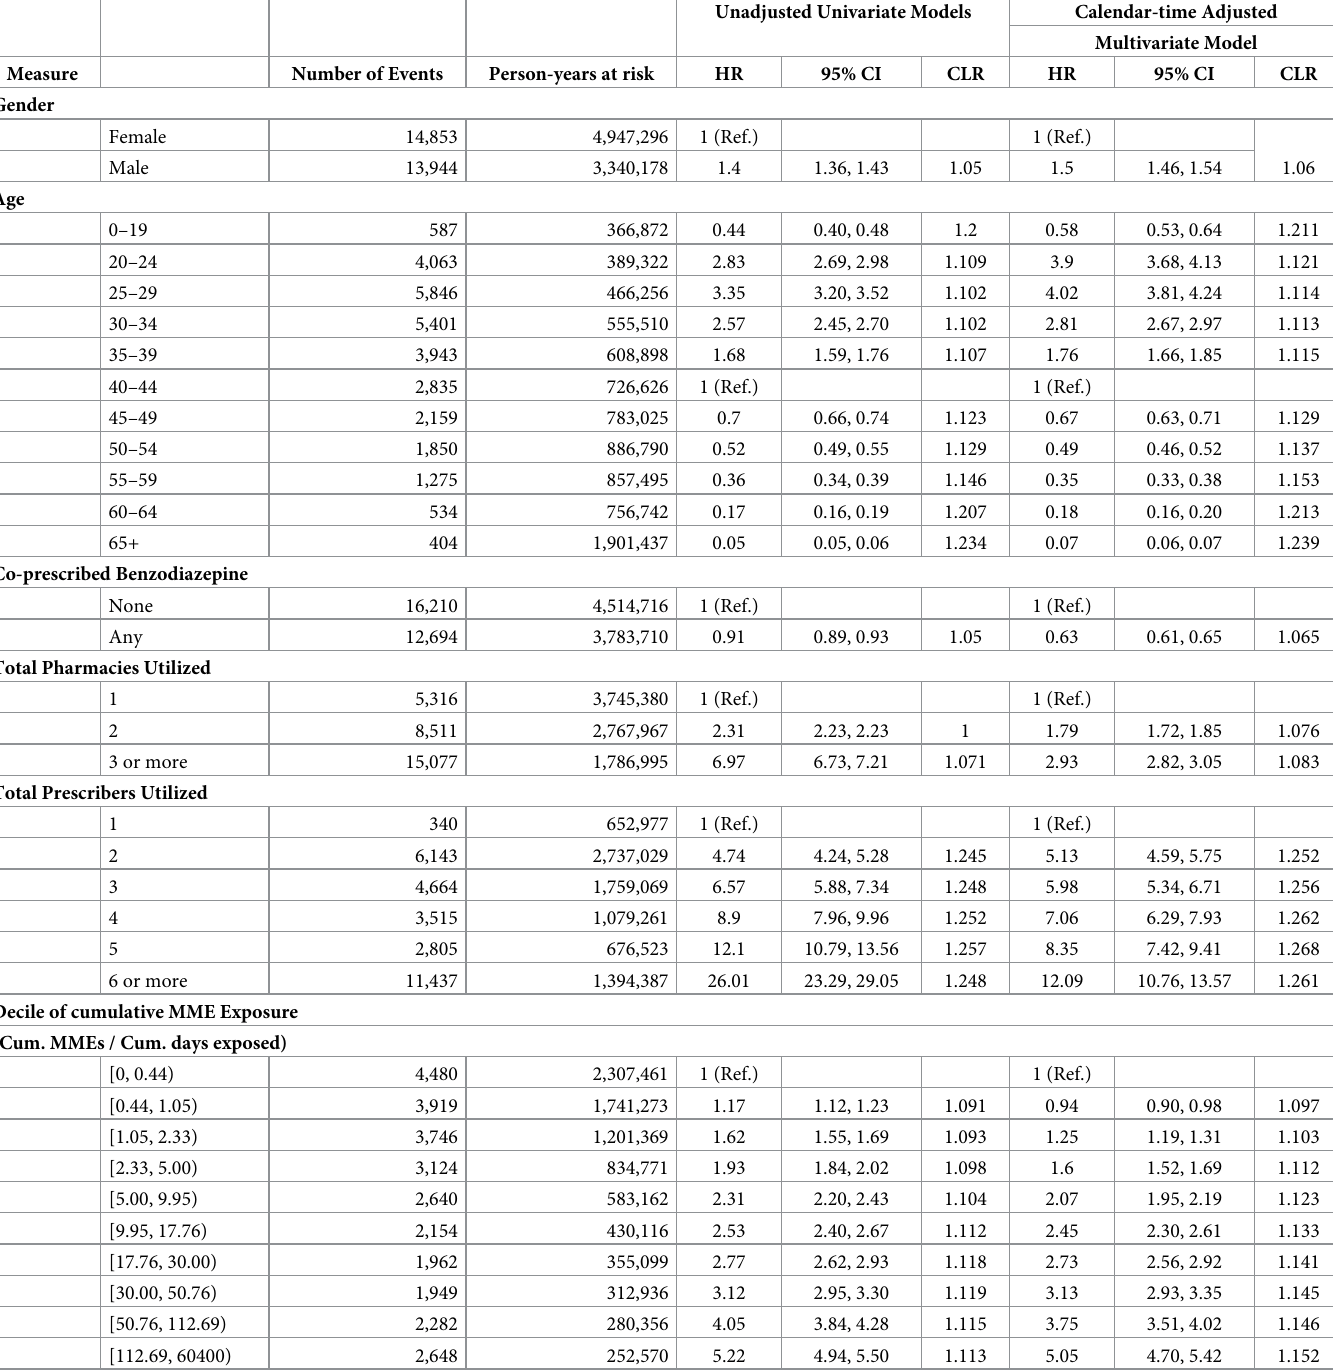
Table 2. Proportional hazards regression of first buprenorphine initiation among North Carolina opioid analgesic recipients, 2011–2015.